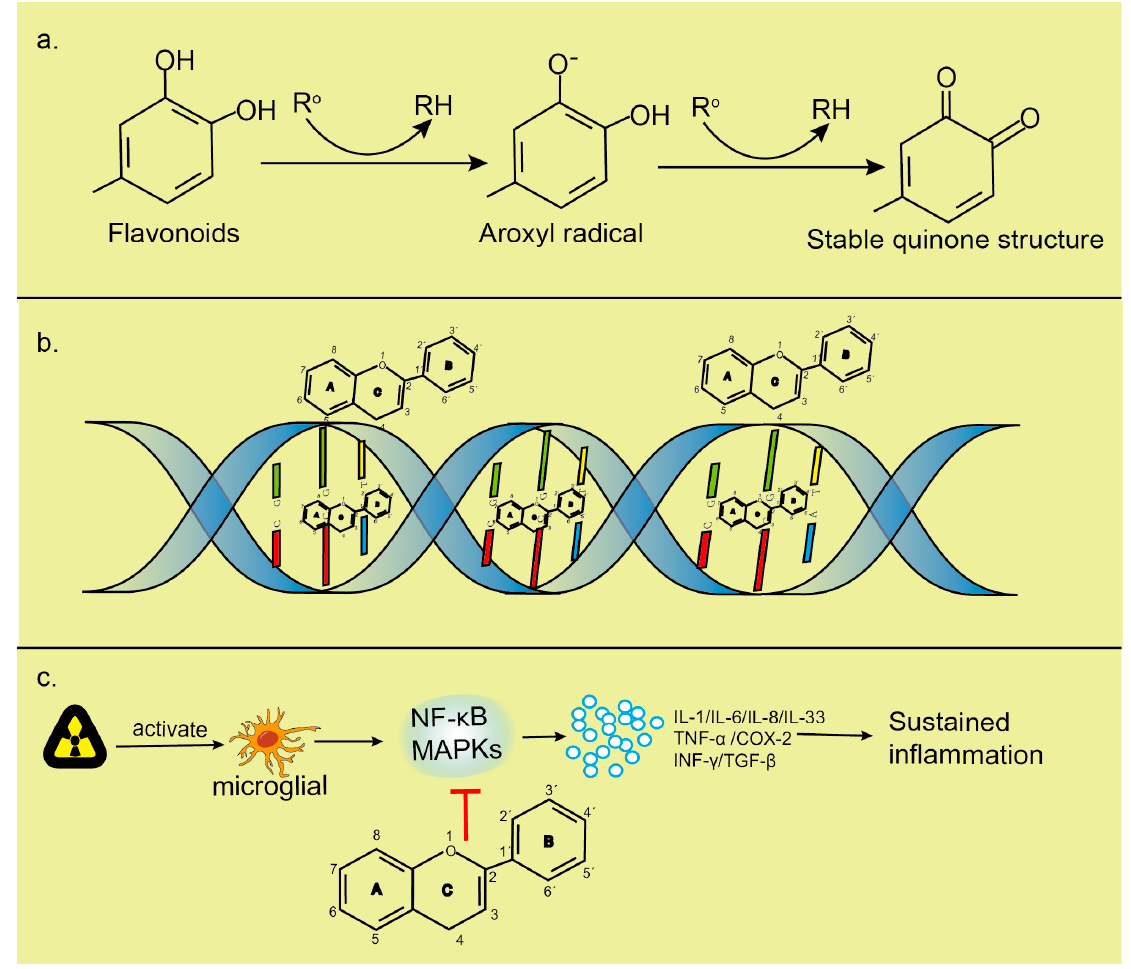
Figure 4. ( a ). Flavonoids are able to reduce highly oxidizing free radicals with redox potentials, such as superoxide, peroxyl, alkoxyl and hydroxyl radicals, by hydrogen atom donation. R o represents superoxide anion, peroxyl, alkoxyl and hydroxyl radicals. The aroxyl radical may react with a second radical, acquiring a stable quinone structure. ( b ). Intercalation of flavonoids into DNA double helices induces stabilization of DNA helical structures and condensation of DNA to a highly compact form that is less susceptible to attacks by free radicals; flavonoids can interact with the phosphate moiety of the DNA backbone through hydrogen bonding. The repair of sugar radicals is attributed to hydrogen donation from flavonoids through this bonding. ( c ). Flavonoids inhibit the activation of NF- κ B and MAPK, reduce the release of inflammatory factors and play an anti-inflammatory role.